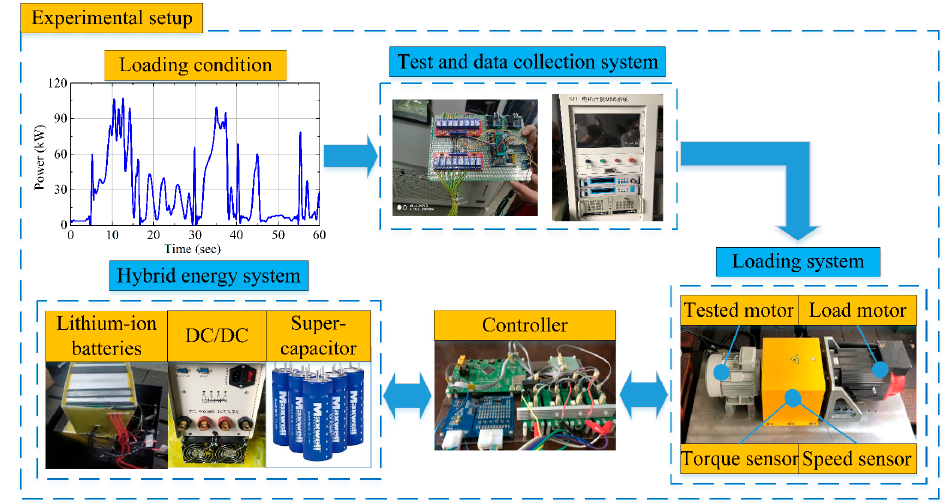
Figure 11. The experimental platform of electric construction machinery.